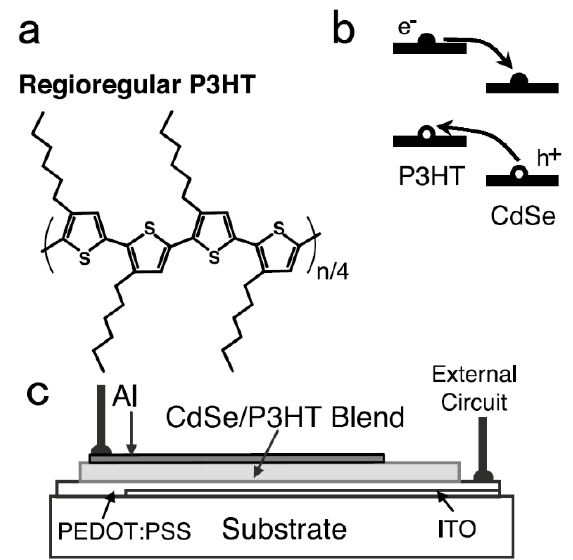
Figure 1. ( a ) The molecular structure of regioregular P3HT . ( b ) The energy level diagram of CdSe nanorods and P3HT with a schematic drawing of electron transfer to CdSe and hole transfer to P3HT. ( c ) The device structure consists of a 200 nm film sandwiched between an aluminum electrode and a transparent hole transfer layer (HTL) of PEDOT:PSS (Bayer AG, Pittsburgh, PA), which was deposited on the indium tin oxide electrode. The active area of the device is 3 mm 2 . This film was spin-cast from a pyridine chloroform solution of 90 wt% CdSe nanorods in P3HT. Reproduced with permission from [18], Copyright © 2002, The American Association for the Advancement of Science .